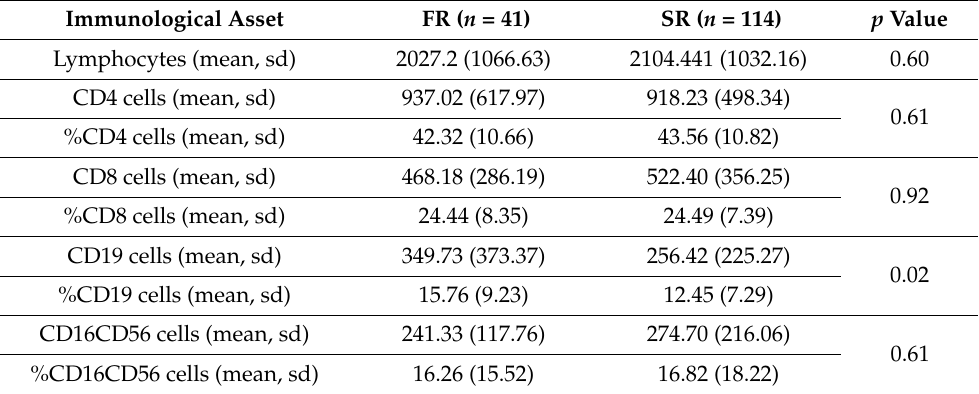
Table 4. Comparison of total lymphocytes and lymphocyte subsets at baseline between patients with fast and slow repopulation rate at six months. Data are reported using mean ± standard deviation (sd).